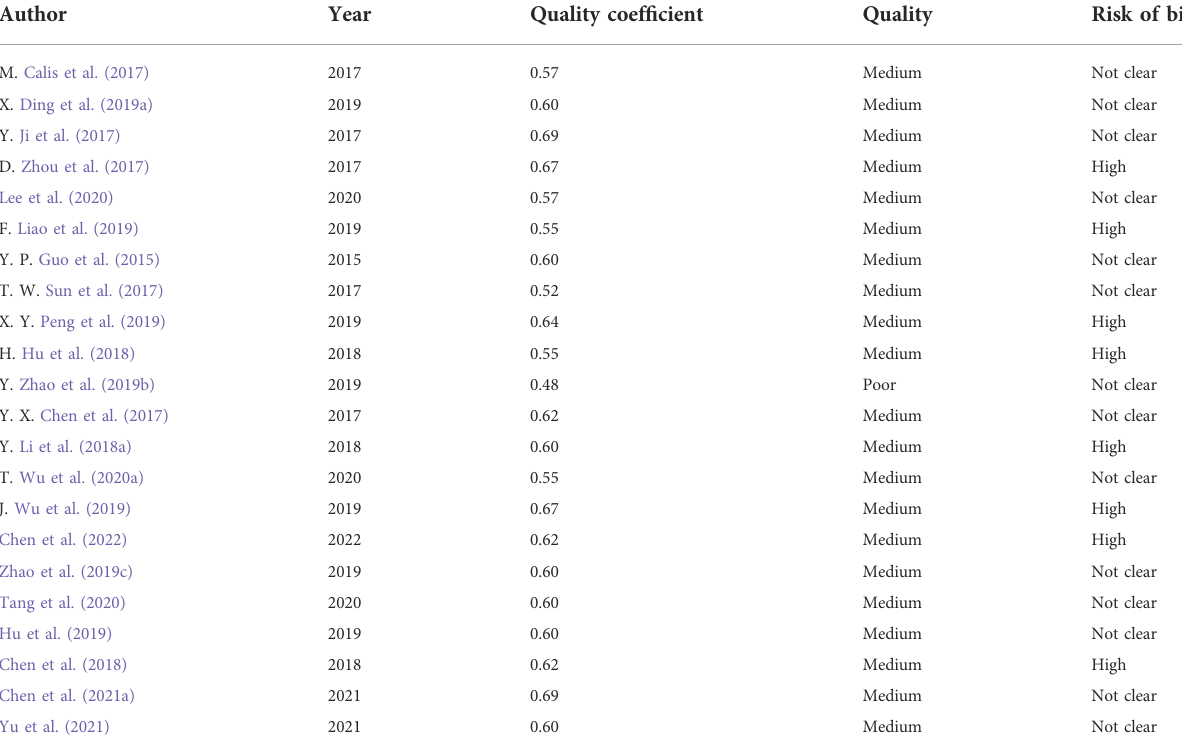
TABLE 8 Results of the quality and general risk of bias of each